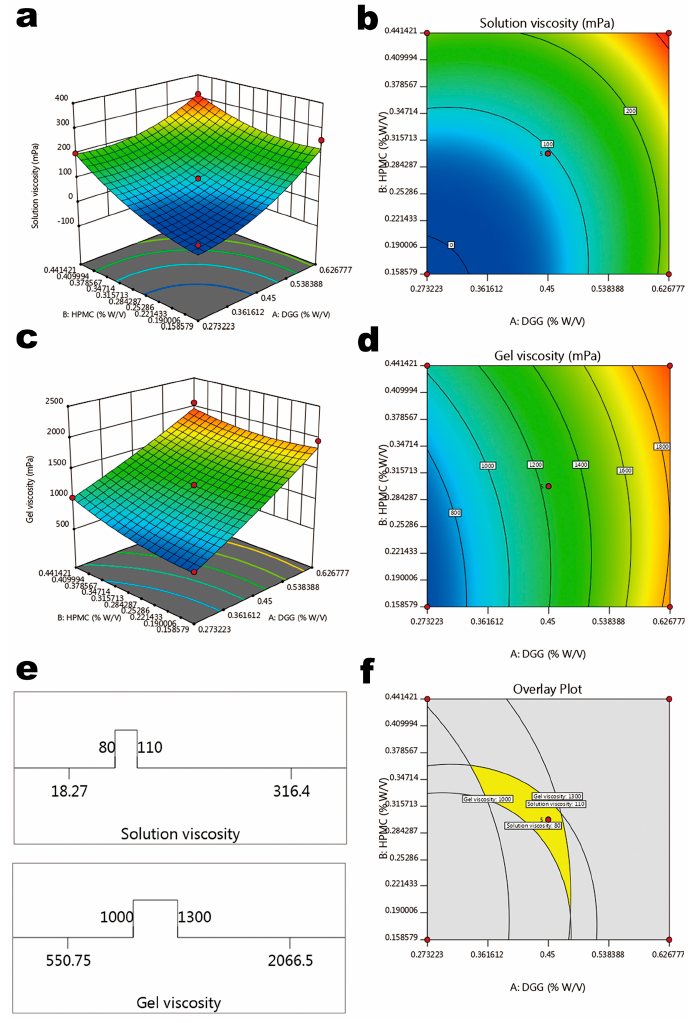
Figure 5. Three-dimensional surfaces and contours showing the influence of DGG and HPMC. ( a ) 3D surface plot of DGG and HPMC on solution viscosity; ( b ) contour of DGG and HPMC on solution viscosity; ( c ) 3D surface plot of DGG and HPMC on gel viscosity; ( d ) contour of DGG and HPMC on gel viscosity; ( e ) target value ranges of solution viscosity and gel viscosity; ( f ) graphical optimization highlighting an area of operability.